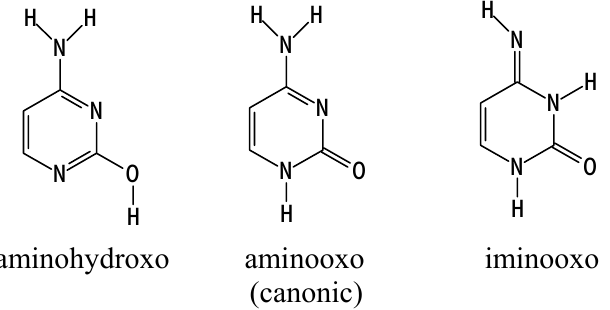
Figure 1. Most stable gas-phase tautomers of